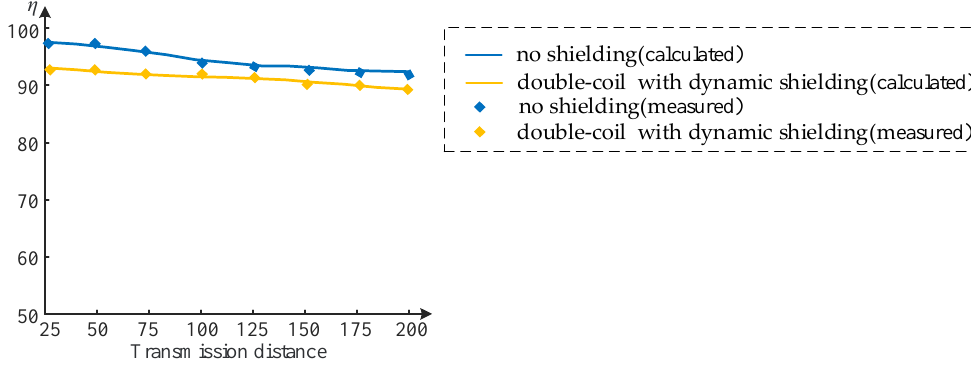
Figure 17. Curves of η at different transmission distances.